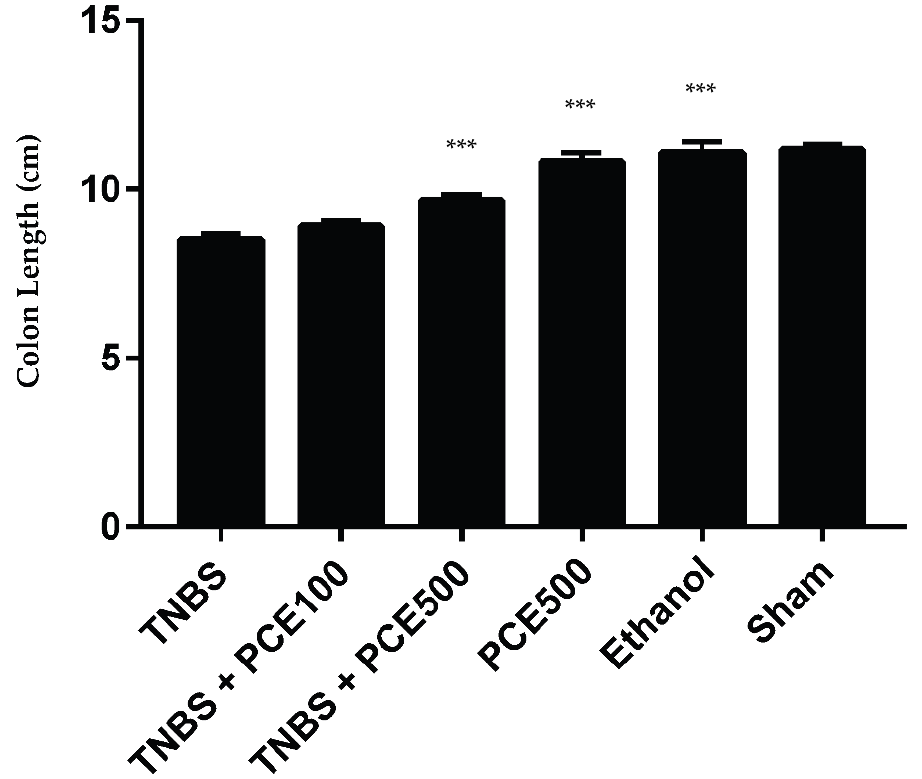
Figure 2. Effect of PCE treatment on colon length in the IBD. The results are represented as mean ± SD [ n (TNBS + PCE100) = 10; n (TNBS + PCE500) = 10; n (PCE) = 10; n (TNBS) = 6; n (ethanol) = 5; n (sham) = 5; *** p < 0.001 compared with TNBS group, one-way ANOVA followed by Tukey’s post hoc test]. Abbreviations: IBD, inflammatory bowel disease; PCE, phenolic compounds extract; TNBS, 2,4,6-Trinitrobenzene sulfonic